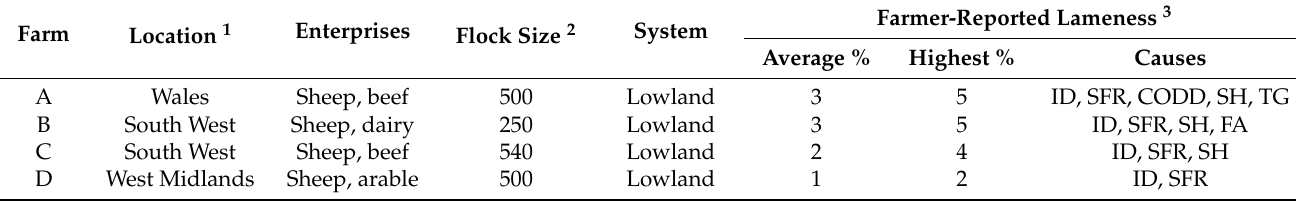
Table 1. Characteristics of the farms and flocks (identified A-D) selected for the